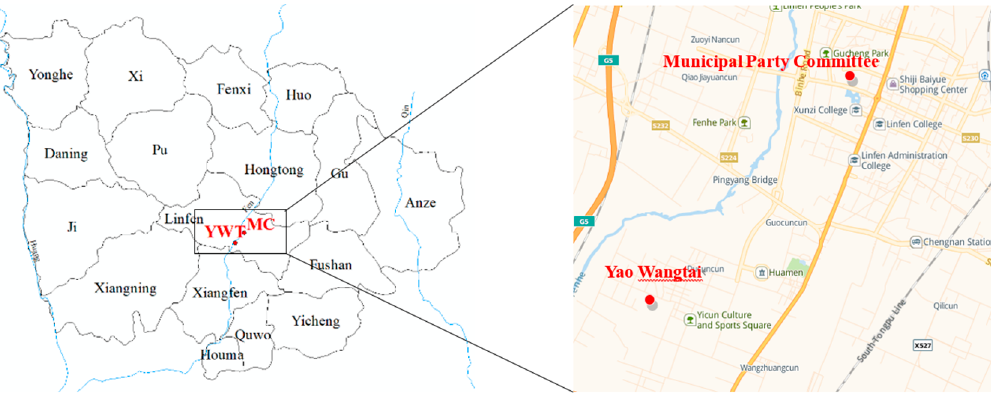
Figure 2. Locations of the two sampling sites in Linfen City.